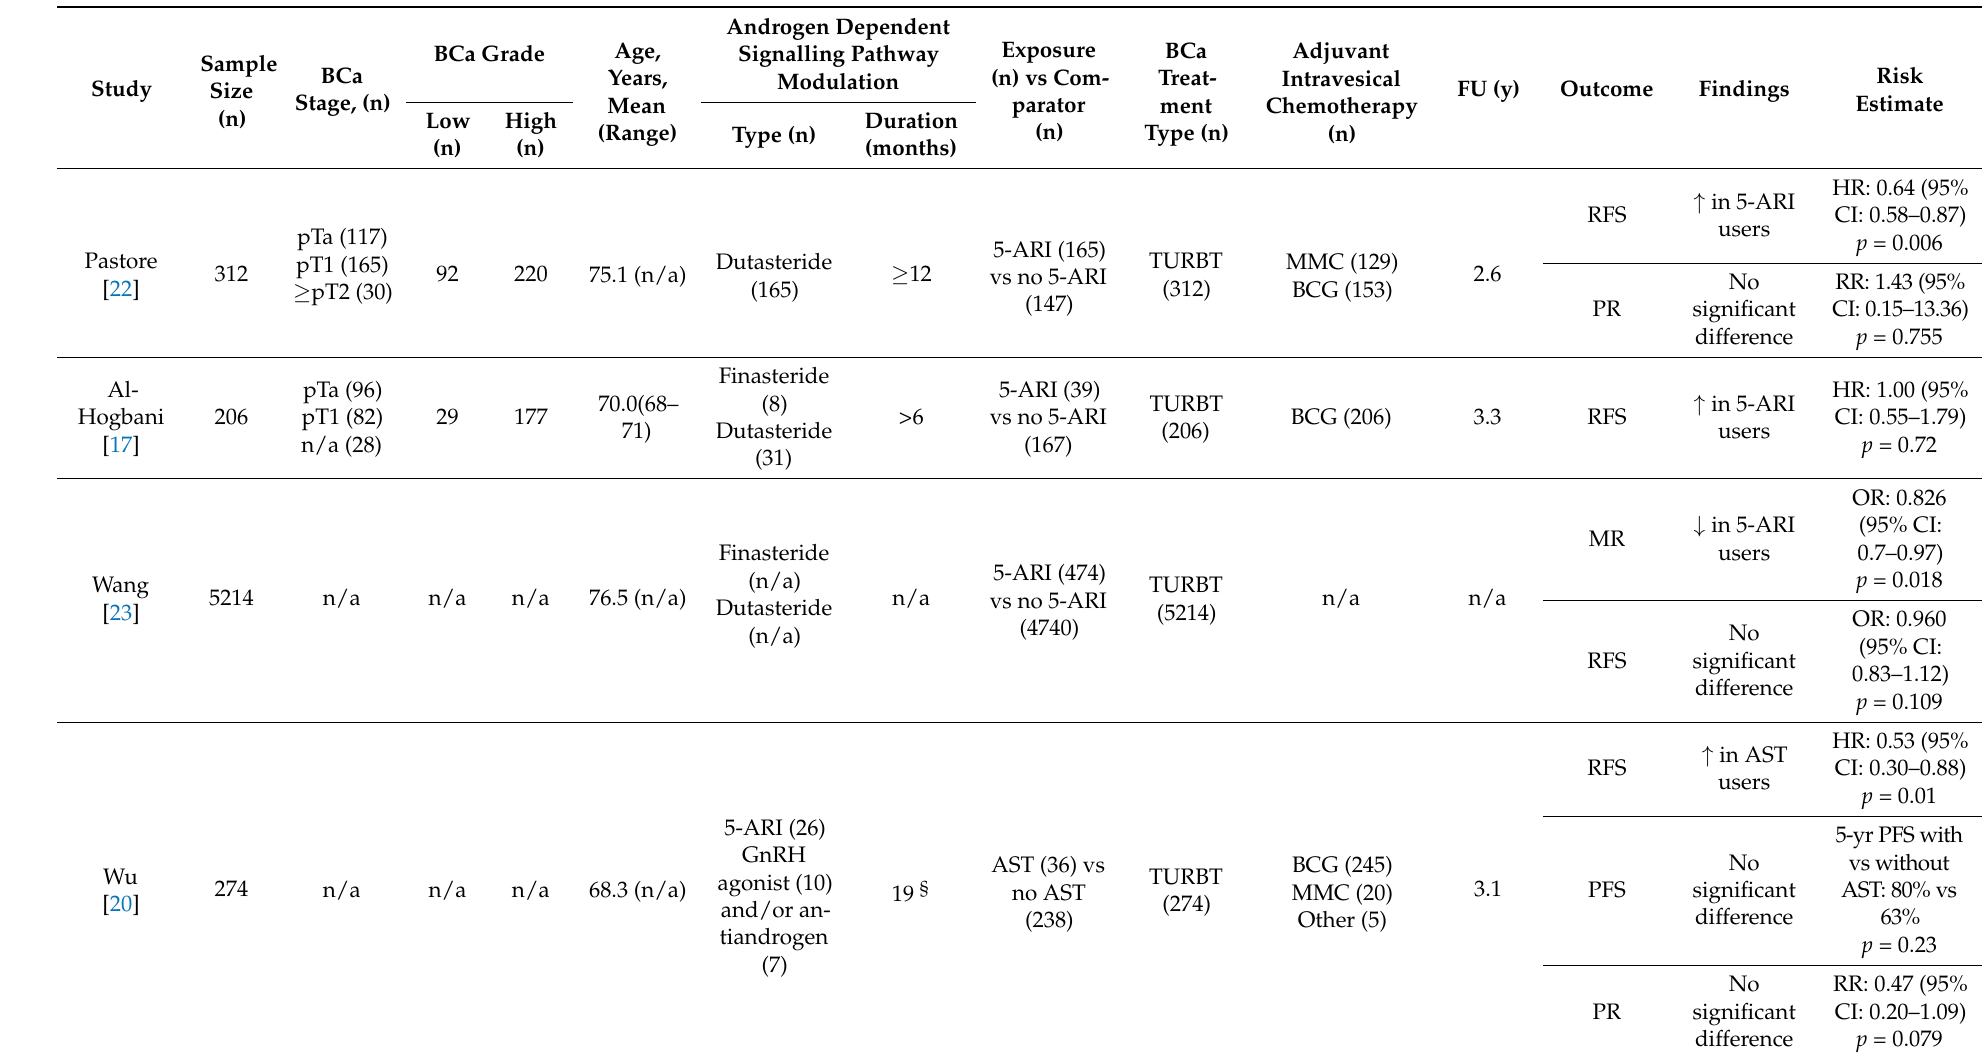
Table 2. Summary of clinical